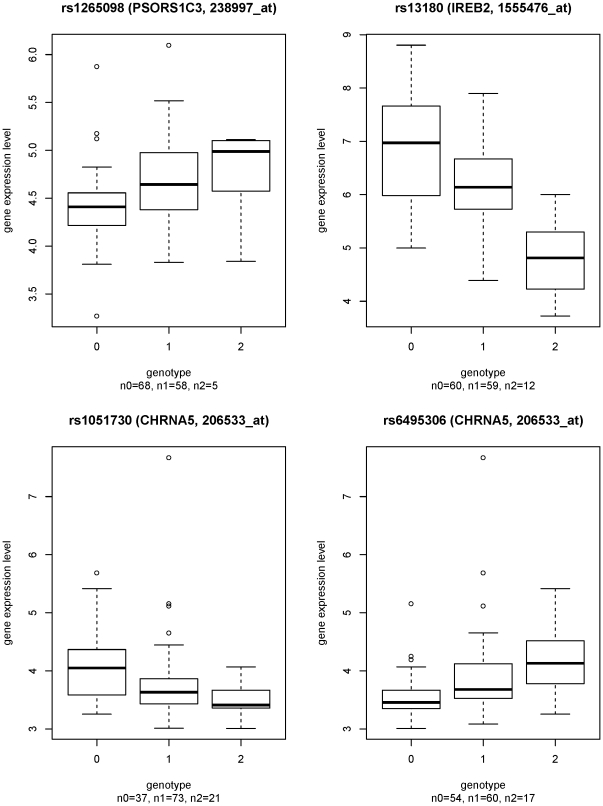
Boxplots of sputum gene expression levels stratified by genotype in 131 Evaluation of COPD Longitudinally to Identify Predictive Surrogate End-points (ECLIPSE) subjects with chronic obstructive pulmonary disease.a) rs1265098 - PSORS1C3 (238997_at), p = 8.2e-5. b) rs13180 - IREB2 (1555476_at), p = 6.7e-9. c) rs1051730 - CHRNA5 (206533_at), p = 2.2e-4; LD bin 1 (see Table 4). d) rs6495306 - CHRNA5 (206533_at), p = 9.9e-6; LD bin 3 (see Table 4).